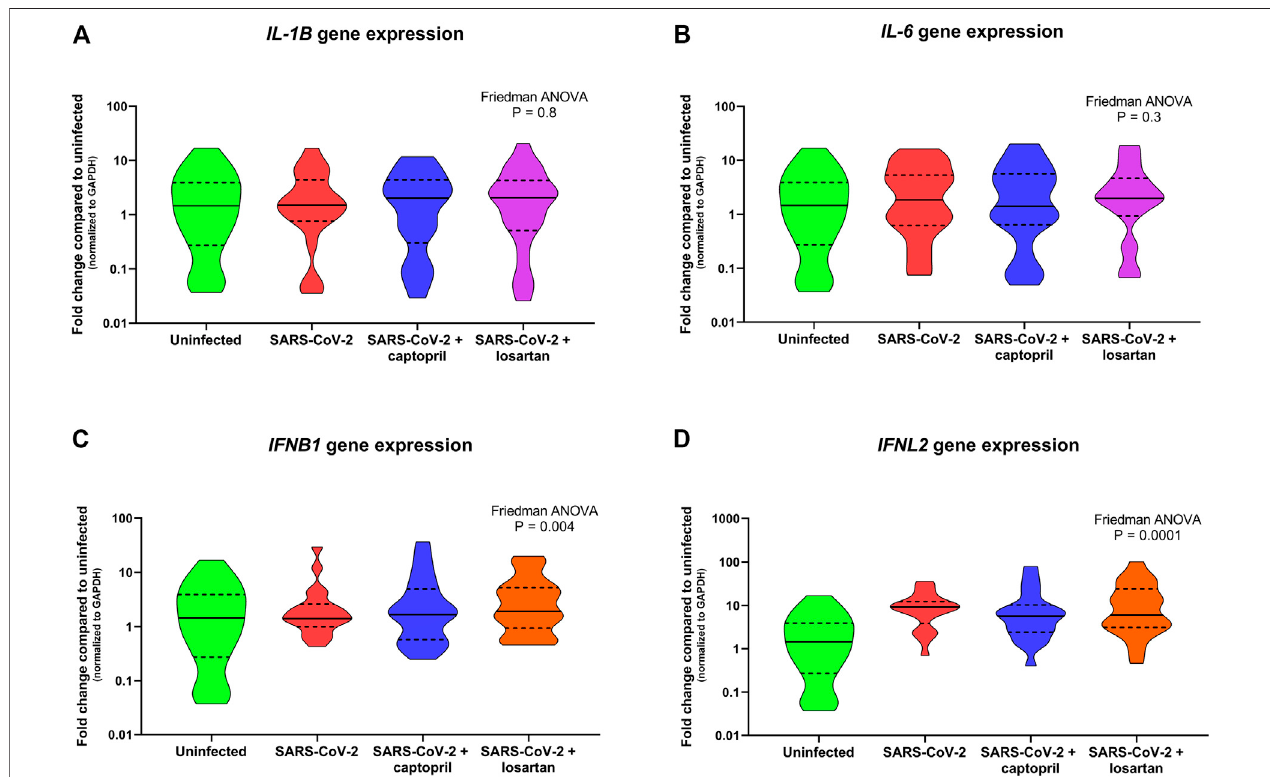
FIGURE 5 | Relative gene expression of IL-1B, IL-6, IFNB1 , and IFNL2 (normalized to GAPDH expression) by organotypic bronchial airway epithelial cell cultures from children ( n (cid:1) 12) and older adults ( n (cid:1) 7). Expression of IL-1B was not signi fi cantly different between uninfected, SARS-CoV-2 infected, or SARS-CoV-2 infected cultures with or without treatment with captopril or losartan [ (A) Friedman ANOVA p (cid:1) 0.8]. Expression of IL-6 was also not signi fi cantly different between uninfected, SARS-CoV-2 infected, or SARS-CoV-2 infected cultures with or without treatment with captopril or losartan [ (B) Friedman ANOVA p (cid:1) 0.3]. Expression of IFNB1 and IFNL2 were signi fi cantly greater by SARS-CoV-2 infected cultures compared to uninfected cultures [ (C) Friedman ANOVA p (cid:1) 0.004; (D) Friedman ANOVA p (cid:1) 0.001]; however, there was no difference in IFNB1 or IFNL2 expression between SARS-CoV-2 infected cultures with or without treatment with captopril or losartan. Median indicated by bold lines and quartiles indicated by dashed